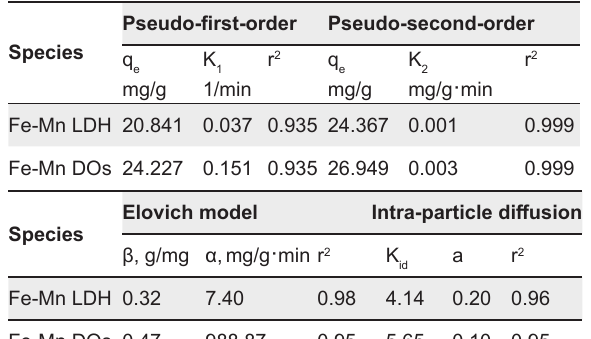
Table 1. Summary of Se(IV) adsorption kinetics parameters by Fe-Mn DOs and Fe-Mn LDHs